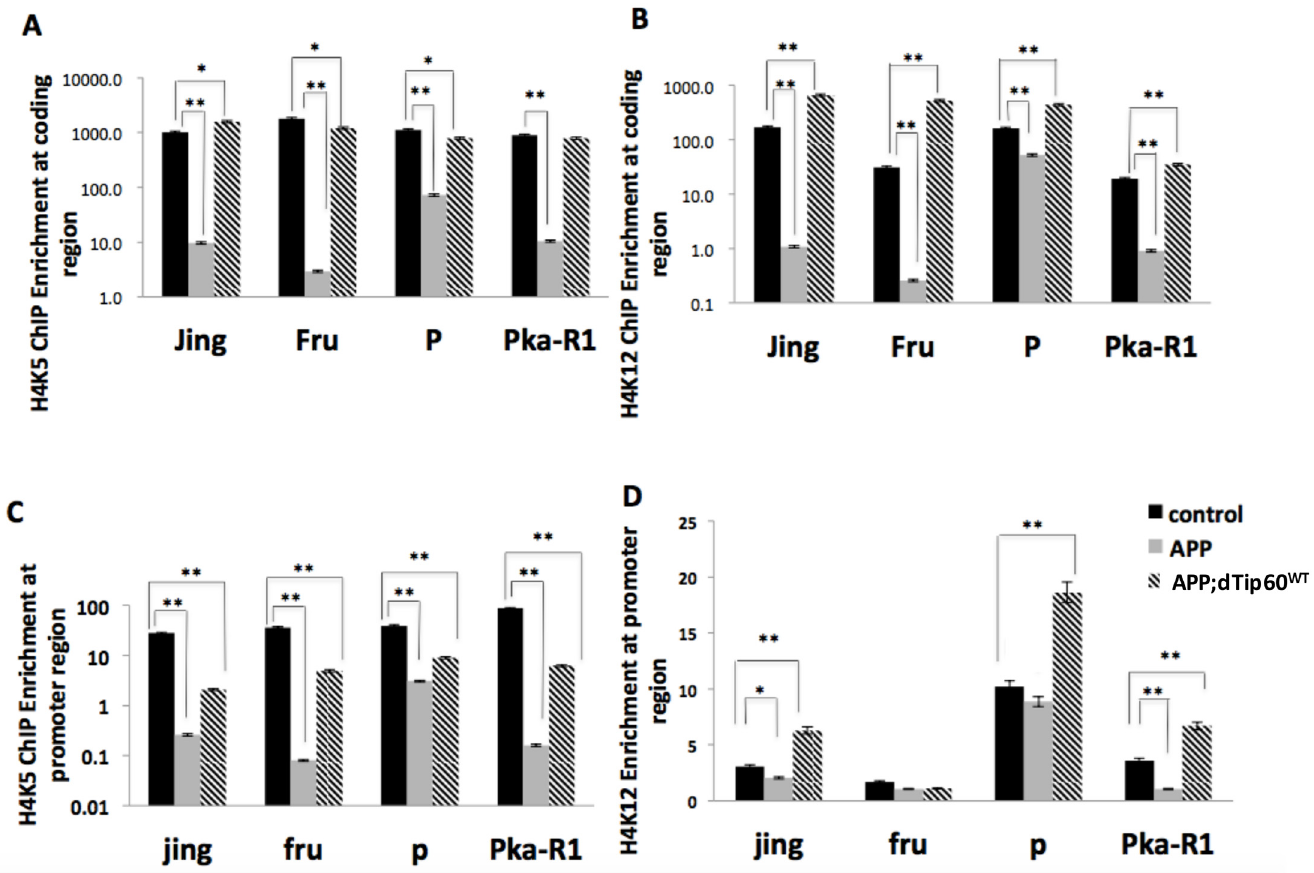
Fig 5. Tip60 HAT activity restores reduced histone acetylation at both promoter and gene coding regions of EE responsive genes under APP neurodegenerative conditions. H4K5ac (A) and H4K12ac (B) enrichment at gene coding region of selected EE responsive genes. H4K5ac (C) and H4K12ac (D) enrichment at the promoter region of same EE responsive genes. Enhanced acetylation levels were observed in wild-type flies, while such EE induced response was reduced in APP flies, and restored with excess Tip60. Excess Tip60 increased EE-induced H4K5 and H4K12 acetylation at both promoter and gene coding regions of selected EE responsive genes (A)H4K5ac ChIP of coding region. (B)H4K12ac ChIP of coding region. (C) H4K5ac ChIP of selected promoter region. (D)H4K12ac ChIP of selected promoter region. Newly eclosed adult fly progeny were exposed to a group of 30 flies (1:1 sex ratio) to generate EE conditions as previously described. Fold enrichment was compared among control, APP and APP;dTip60 WT flies as follows: one-way ANOVA analysis was used to determine the probability that there were differences between the variants. In the cases that ANOVA indicated that there was a significant difference between variants (p < 0.05), we performed post hoc pair-wise comparisons using the Bonferroni correction to determine the significance between each genotype. ** P < 0.01, * P < 0.05. Fly heads (n > 1000) were collected for ChIP experiments. Error bars indicate